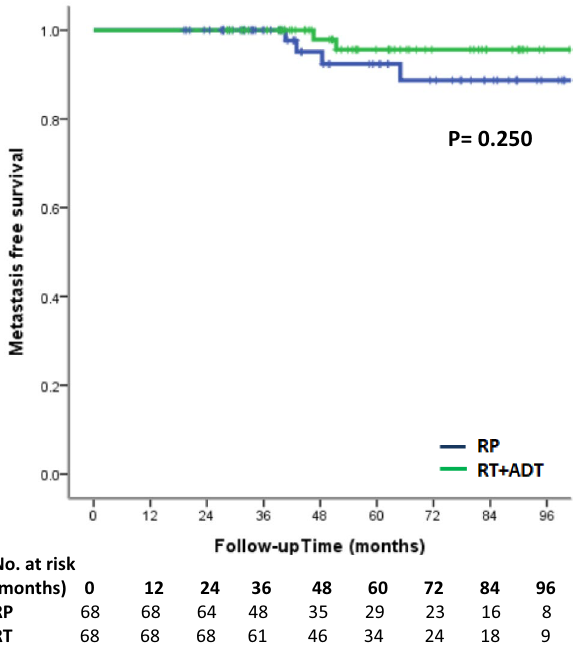
Figure 3. Kaplan–Meier analysis of metastasis free survival in propensity-score matched patients. For each treatment group, we generated Kaplan–Meier survival curves for metastasis according to management method, and we also calculated a log-rank test to evaluate the association of metastasis with different management method among propensity-score matched